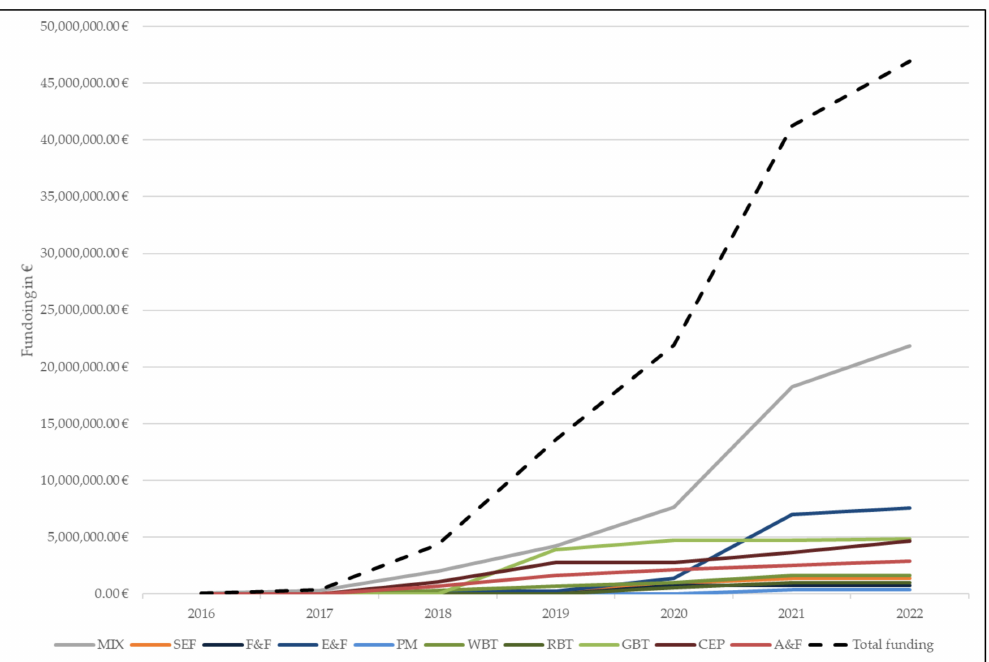
Figure 12. Distribution of funding across bioeconomic thematic areas in the supra-regional bioecon- omy network in the period